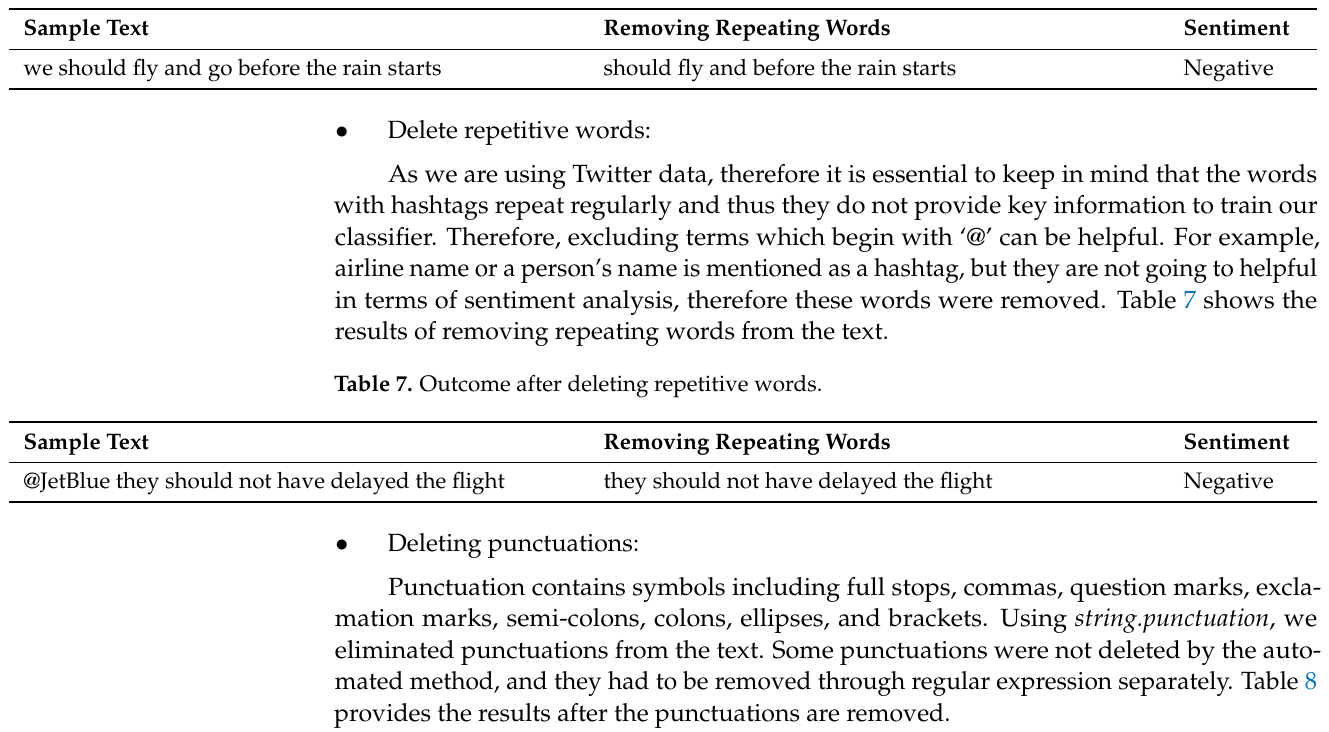
Table 6. Outcome after removing words less than two characters.